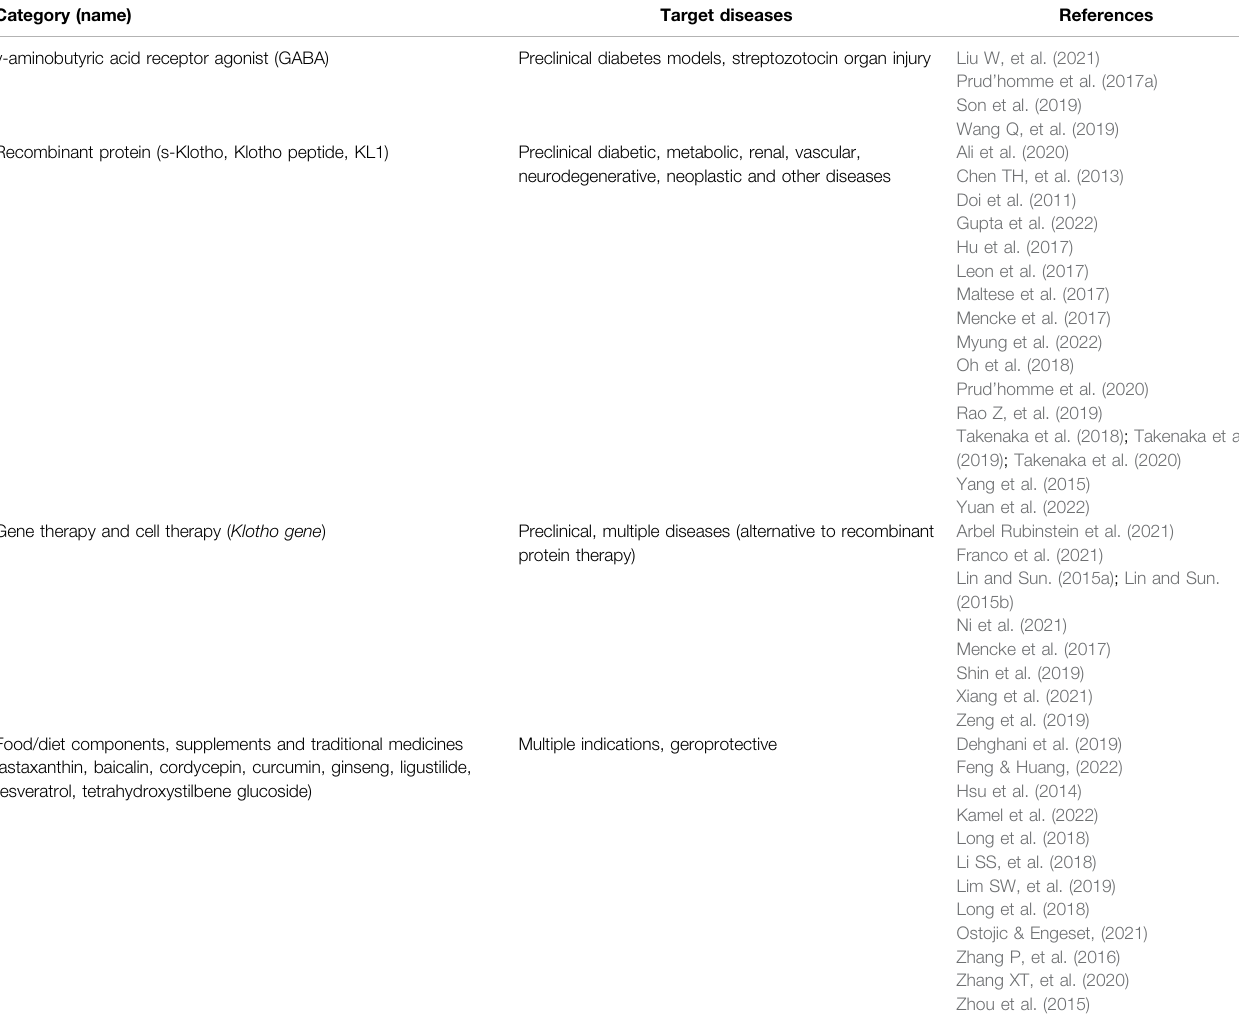
TABLE 3 | Drugs in preclinical development, supplements or other therapies that increase